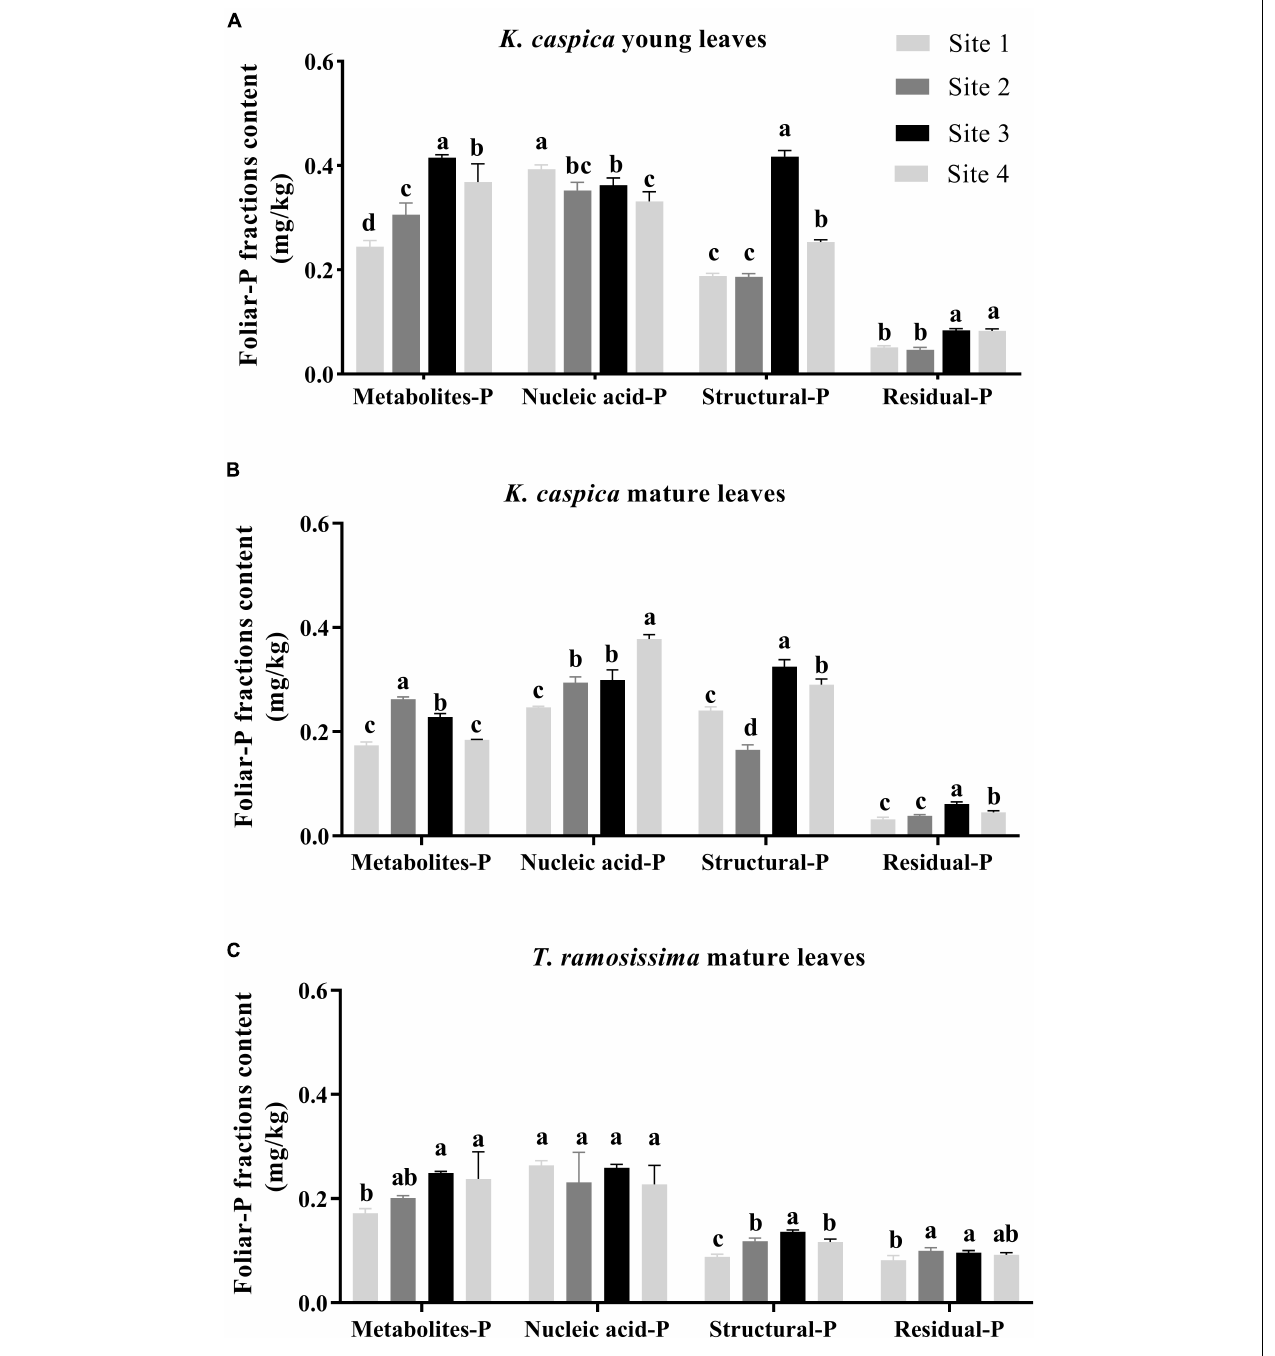
FIGURE 3 | Foliar-P fractions content of two plant species at different environment-P sites. Foliar-P fractions contents of K. caspia young leaves (A) , K. caspia mature leaves (B) , and T. ramosissima mature leaves (C) , respectively. Error bars represent means ± standard deviation (SD, n = 3). Different lower-case letters indicate significant differences of the same foliar-P fraction among the sites ( p < 0.05).